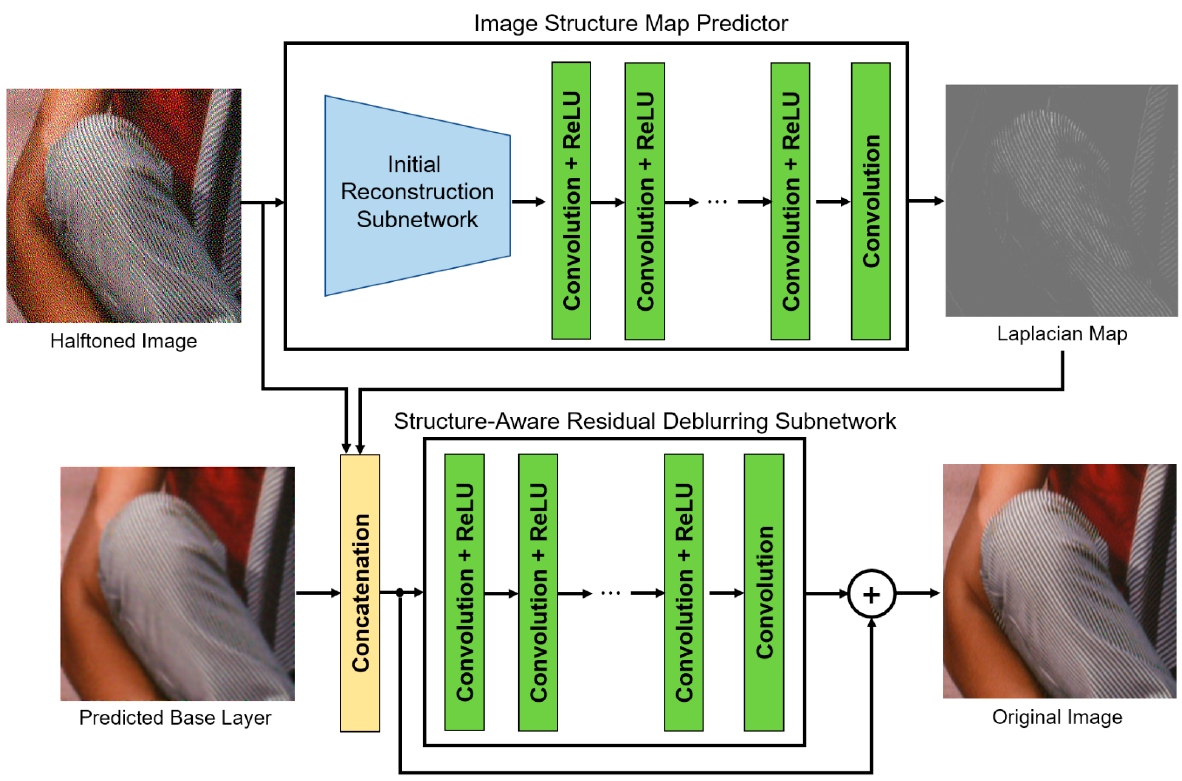
Figure 5. Proposed SALDL for inverse halftoning.